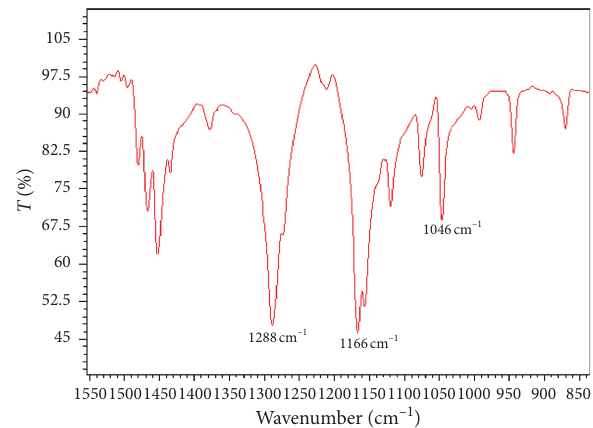
Figure 3: Solid-state FT-IR spectrum of the residual solid resulting from the dibenzothiophene